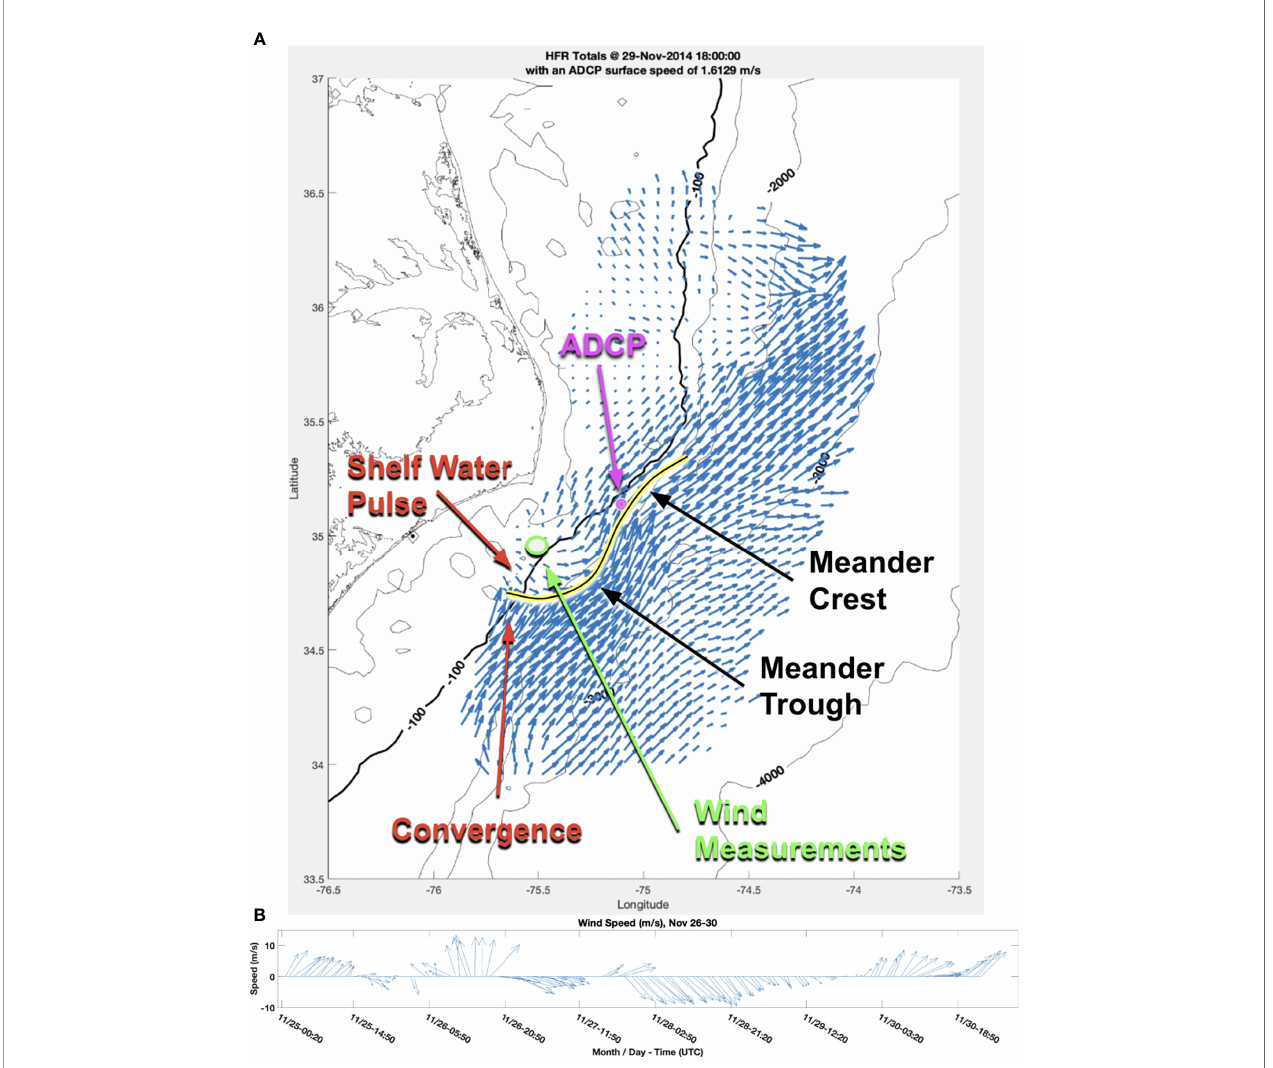
FIGURE 10 | HFR surface currents (A) on November 29th at 18:00 GMT with shelf water pulse, meander, and convergence, and location of wind measurements highlighted. Wind speed and direction timeseries (B) at the location noted in (A) from November 25th through November